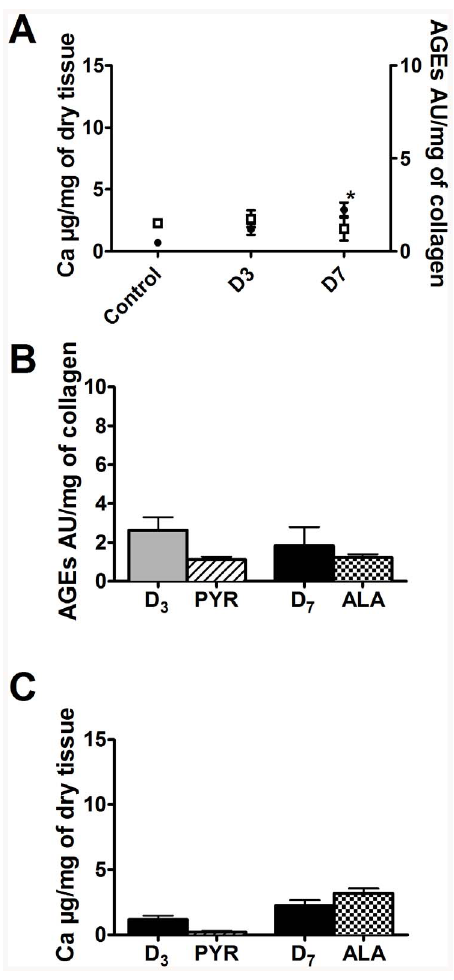
Figure 2. Implication of AGEs in diabetes-accelerated aortic calcification in vivo. (A) Quantification of fluorescent advanced glycation end-products (open squares) and calcium (closed circles) accumulated in the aortic wall. (* p , 0.05 vs Ctrl). Effect of pyridoxamine (PYR) and alagebrium (ALA) on (B) AGEs and (C) calcium accumulation in aortae. For convenience and because no hemodynamic differences were observed, the two control groups were pooled for the experiments presented in panel